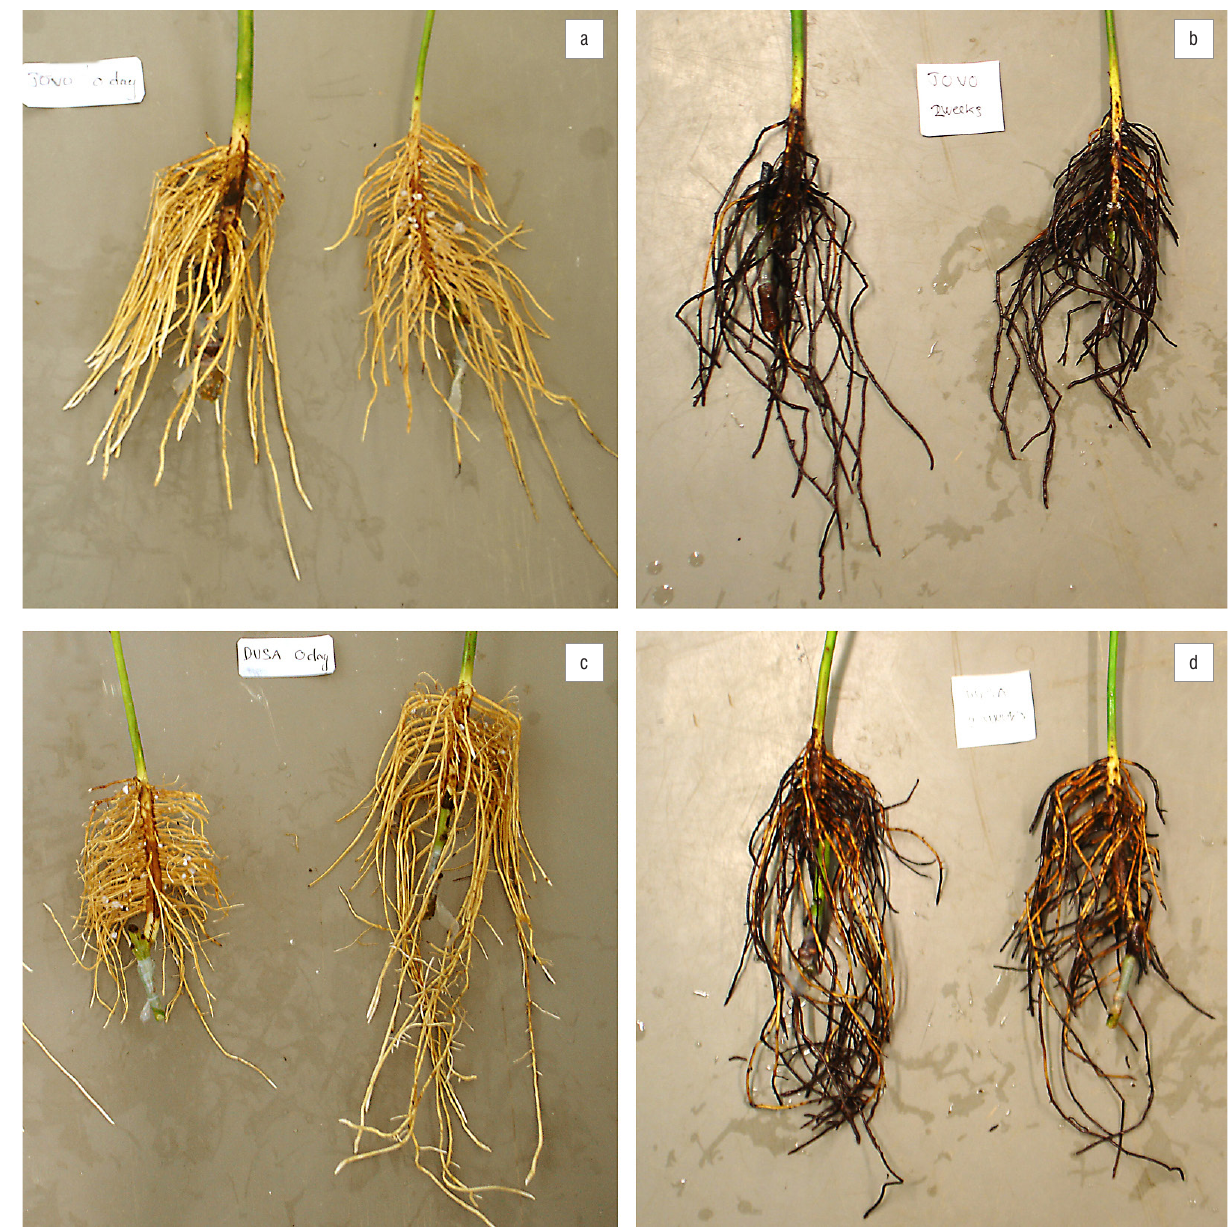
Figure 2: Root symptoms on Dusa ® (highly tolerant) and R0.12 (less tolerant) avocado rootstocks after Phytophthora cinnamomi infection: R0.12 roots at (a) 0 days post-infection (dpi) and (b) 14 dpi and Dusa roots at (c) 0 dpi and (d) 14